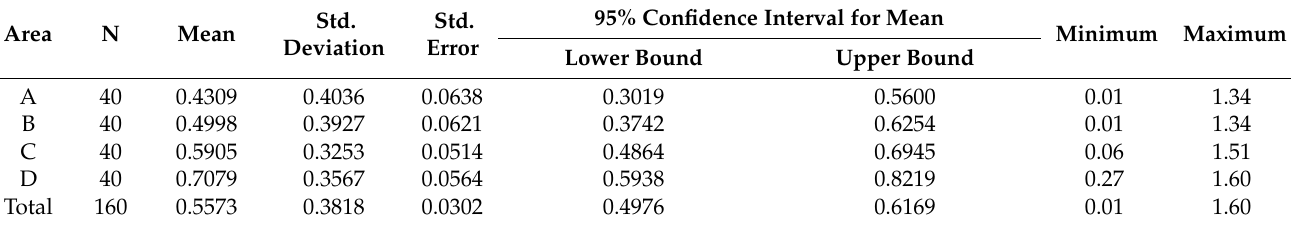
Table 1. Descriptive statistics of produced FCP errors.